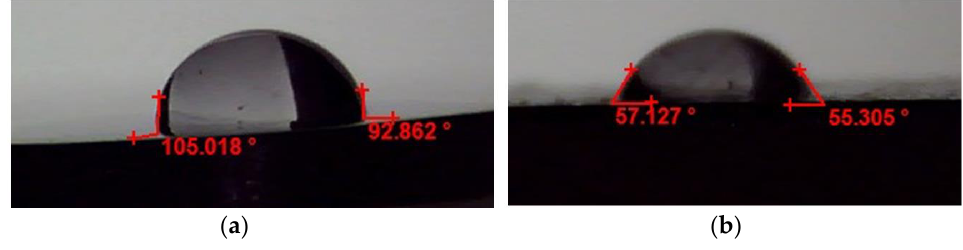
Figure 7. Contact angle values of the samples ( A ) Ti-40, ( B ) Ti-Nb.